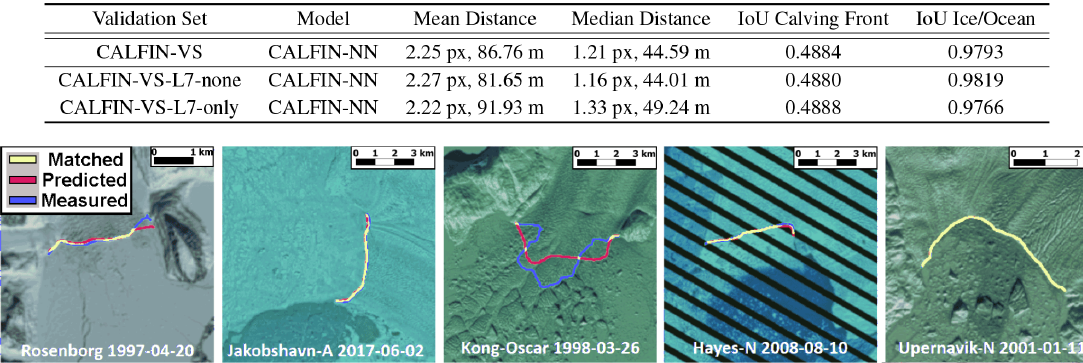
Figure 9. CALFIN-VS validation output results. Yellow represents human (green) and machine (red) agreement on the front location. Note that the drop in mean pixel distance despite the increase in mean meter distance (and vice versa) comes from L7SCE images being reprocessed at lower sizes due to detection failures (see Fig. 6c) and pixel error bias being inversely related to input size (see Sect. 4.1).